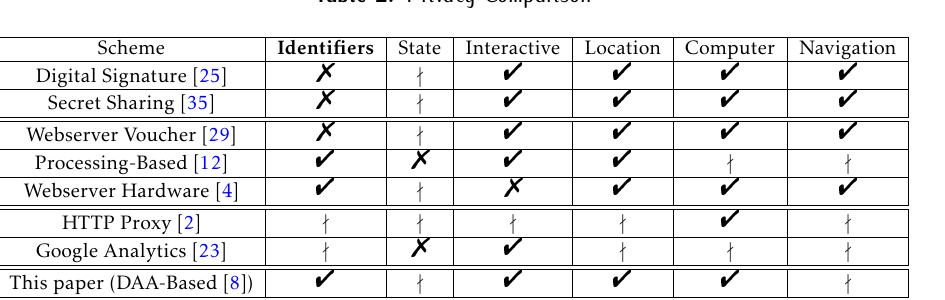
Table 2. Privacy